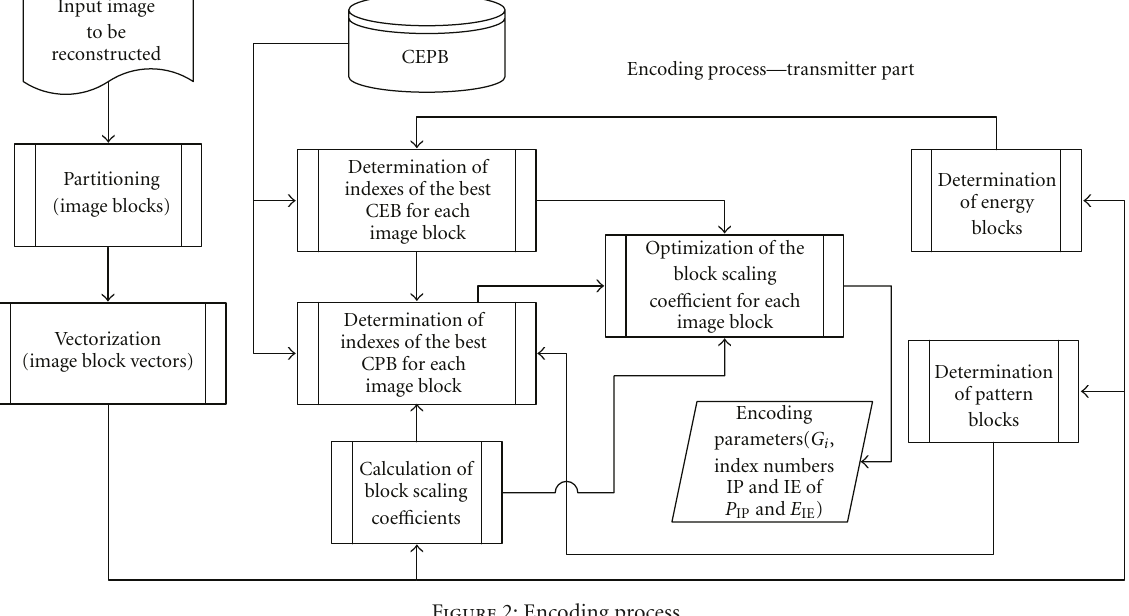
Figure 2: Encoding process.